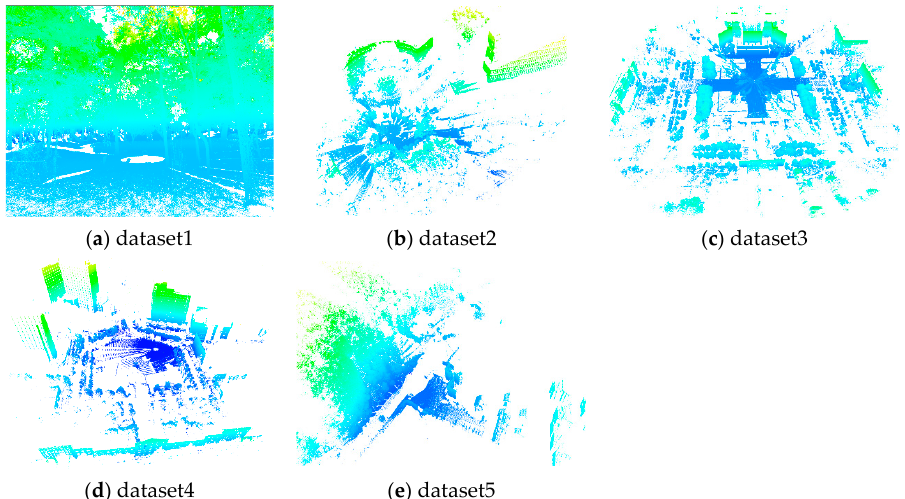
Figure 7. Comparison of three density definitions. ( a ) Scanline and surrounding objects, ( b ) Tradi- tional projection density, ( c ) Reference projection density, ( d ) Relative projection density.